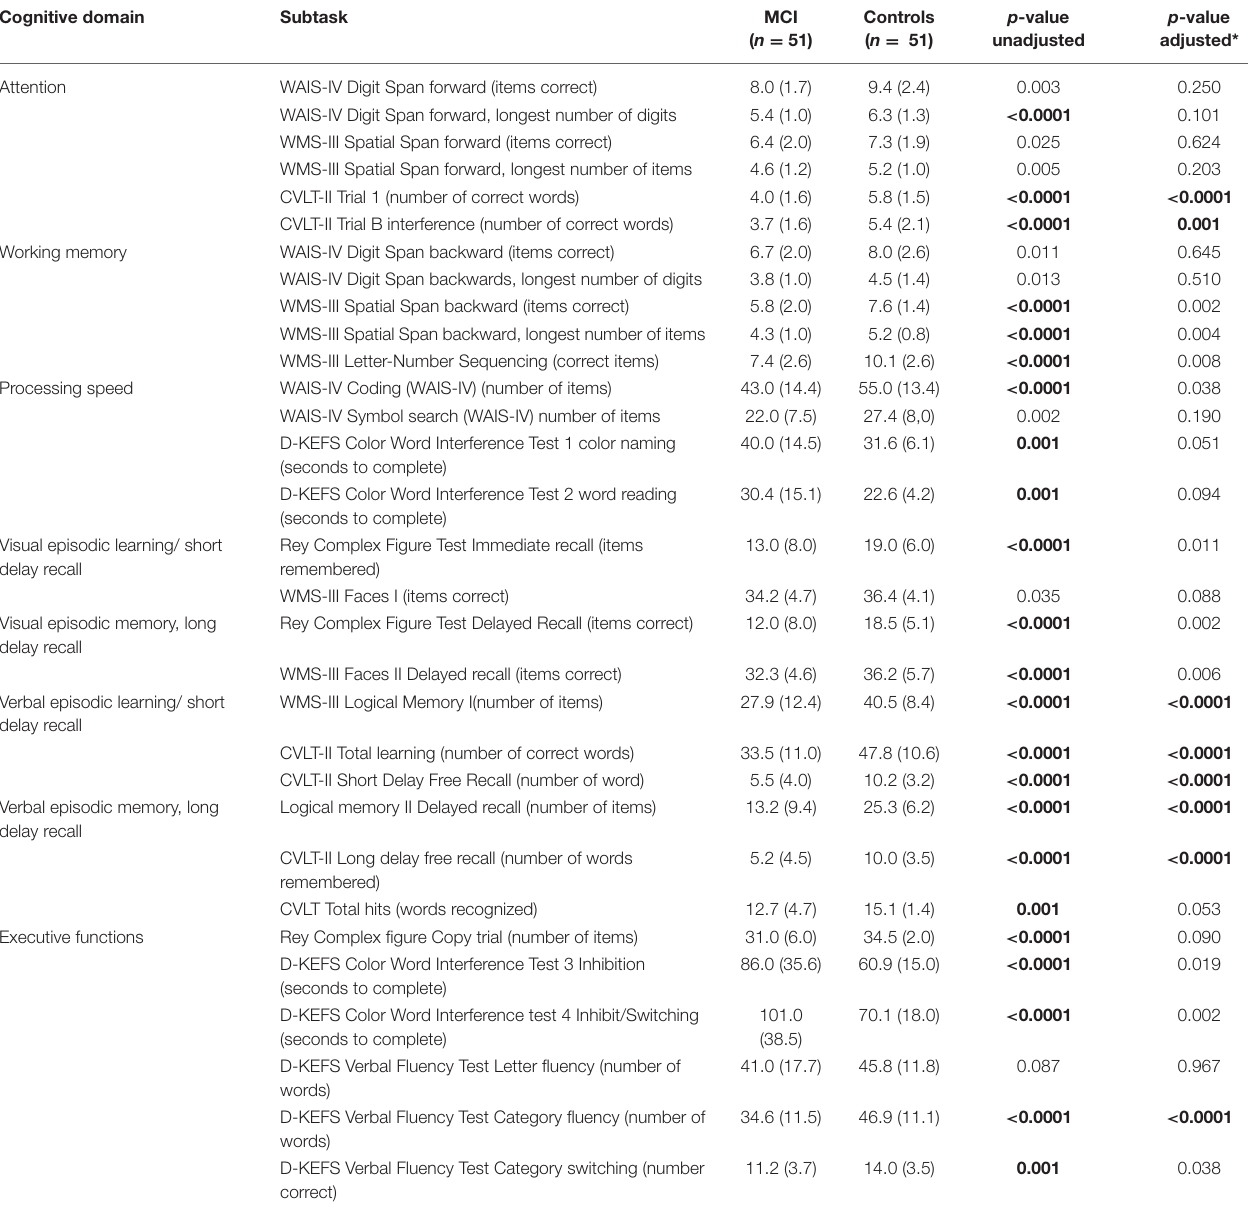
TABLE 5 | Neuropsychological test results in patients with MCI ( n = 51) compared to matched controls ( n = 51). Cognitive domain